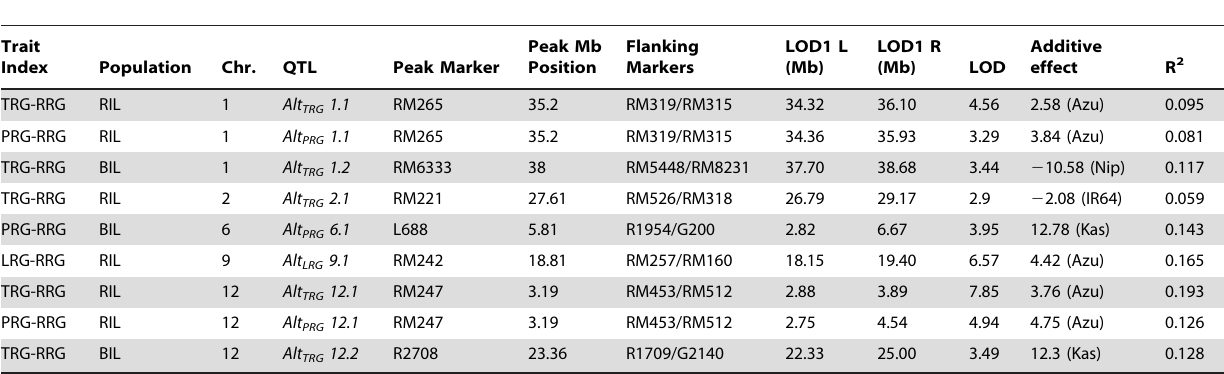
Table 1. Summary of significant QTLs (1000 permutations) identified by composite interval mapping in the RIL and BIL